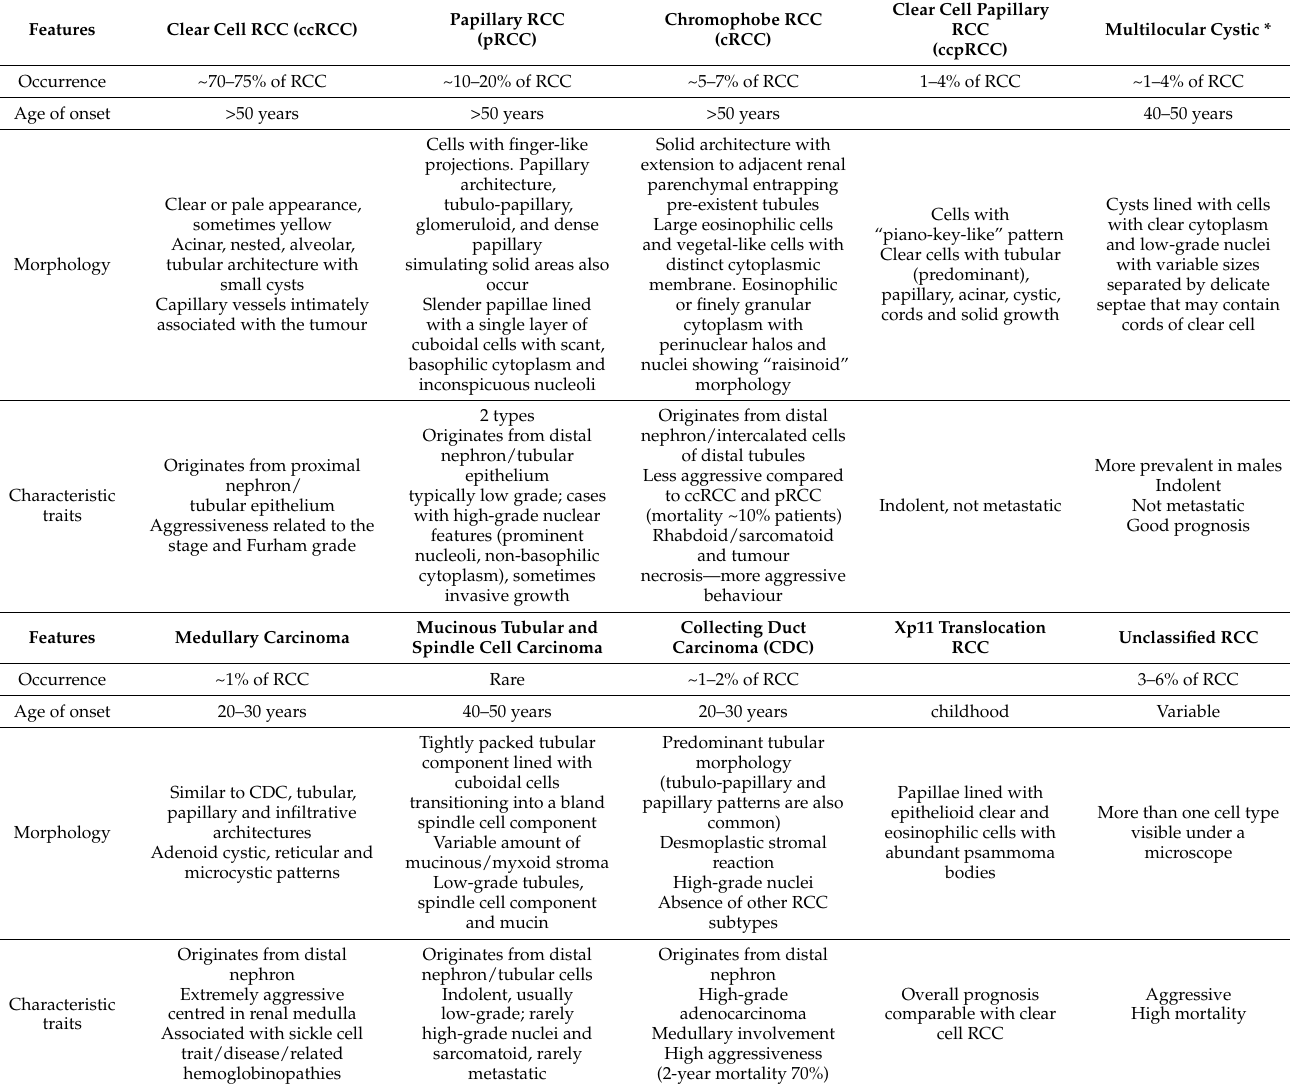
Table 1. Summary of features of various subtypes of